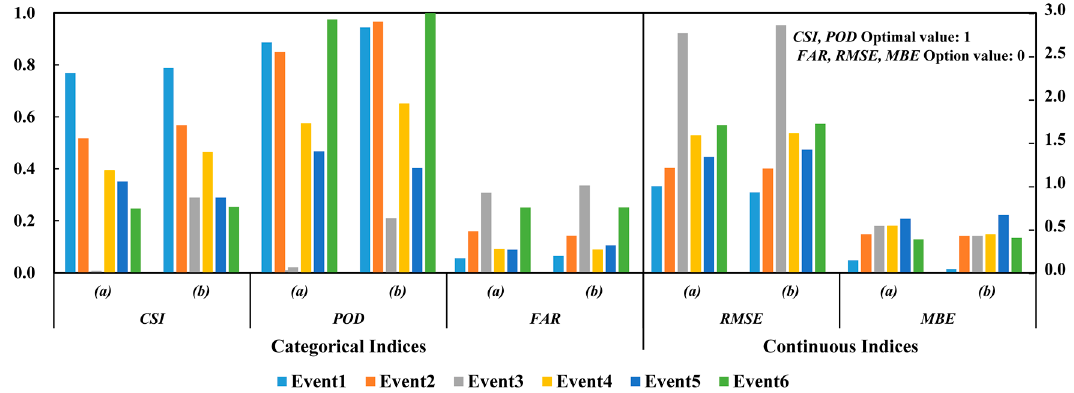
Figure 3. Evaluation values of the indices for the temporal rainfall distribution of the six storm events: ( a ) WRF-only; ( b ) the fully coupled WRF / WRF-Hydro.